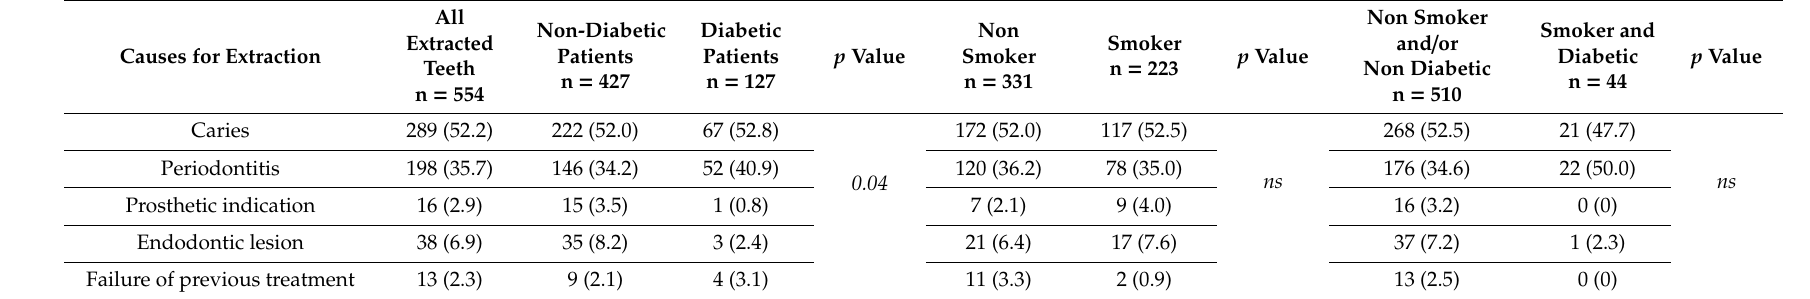
Table 4. Causes for extraction stratified for risk